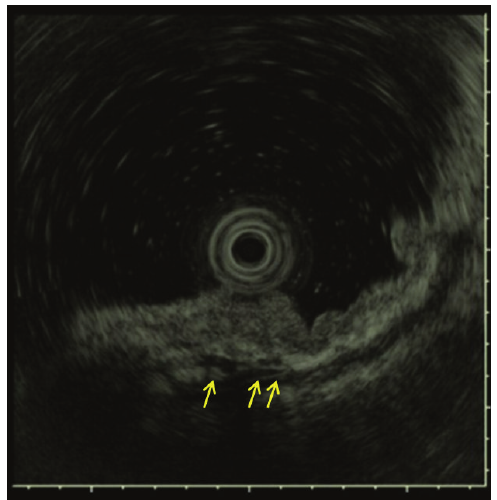
Figure 6: EUS image of the lesion of Figure 5. EUS showing some large vessels approximately 1000 𝜇 m in diameter in the third layer (yellow arrow).